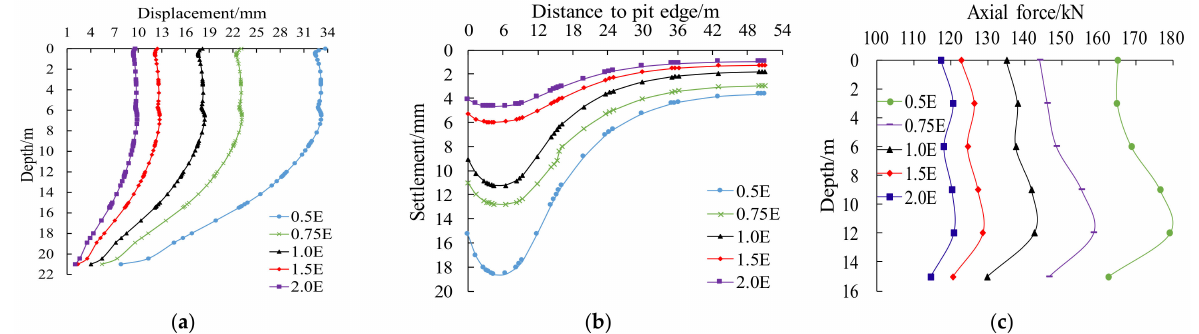
Figure 21. Influence curve of different elastic modulus: ( a ) Horizontal displacement of piles, ( b ) Ground settlement, ( c ) Axial force.